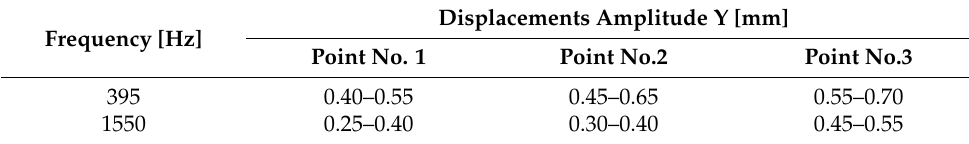
Table 4. Measured displacements amplitude at the points 1, 2, and 3.